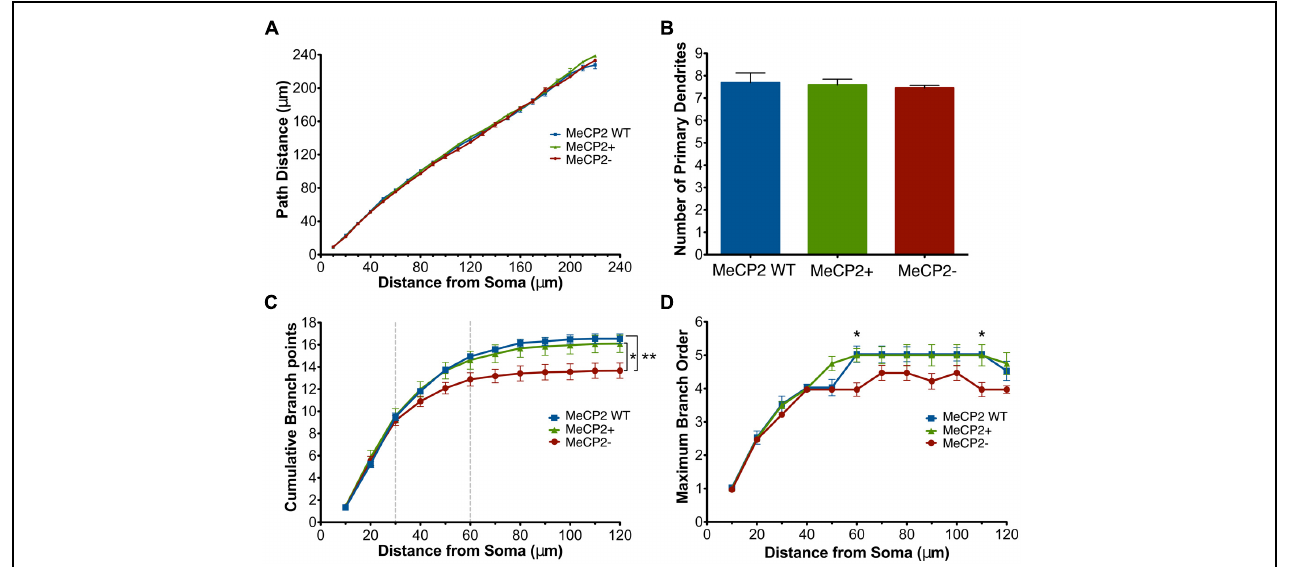
FIGURE 5 | MeCP2 − neurons have a reduction in the number of total branch points and maximum branch order across Sholl radii. (A) Basal dendrites of all genotypes have similar path distances across Sholl radii. (B) All genotypes have the same number of primary dendrites. (C) MeCP2 − neurons have an average of three fewer total branch points (a 17% reduction)